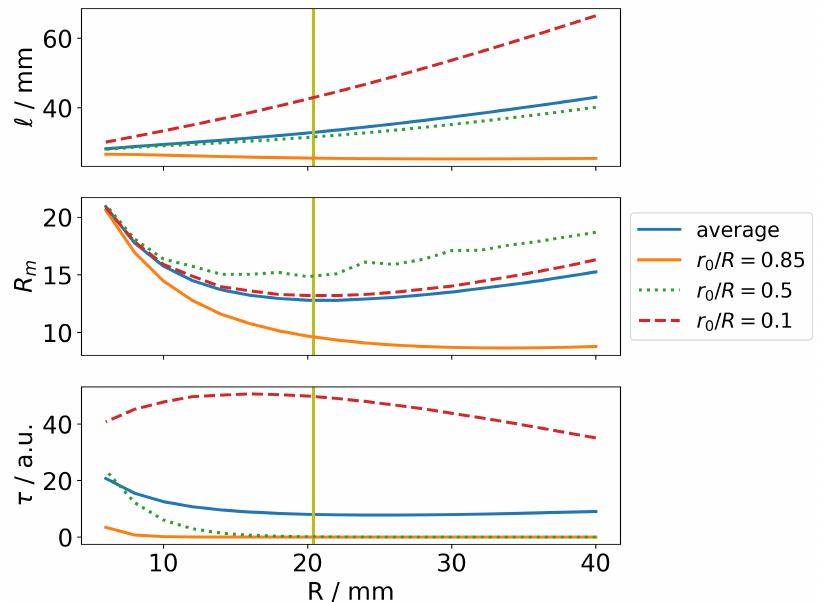
Figure 8. Same as Figure 7, but here, radius R is varied instead of the fixed length L = 50mm. Since R changes, the three selected field lines are plotted for fixed ratios of r 0 / R